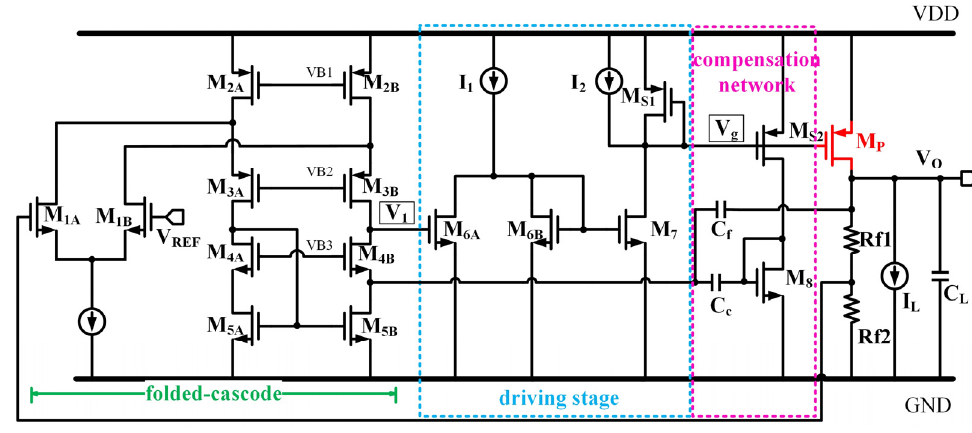
Figure 3. Transistor level schematic of the proposed LDO.